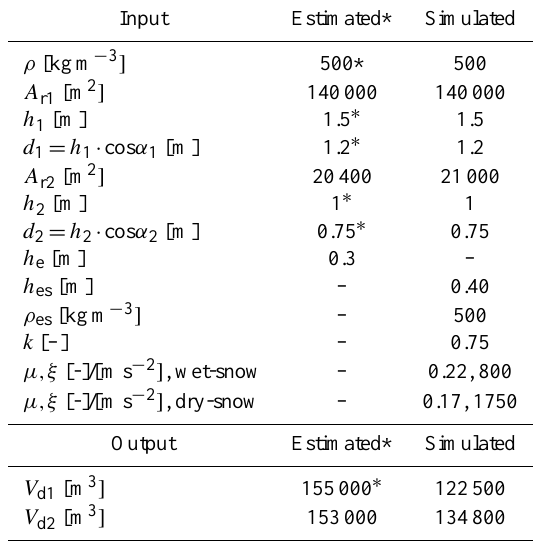
Table 2. Simulation parameters and calculated mass balance. The symbol ∗ indicate parameters whose original value, in Table 1, has been converted using a constant density of 500kgm − 3